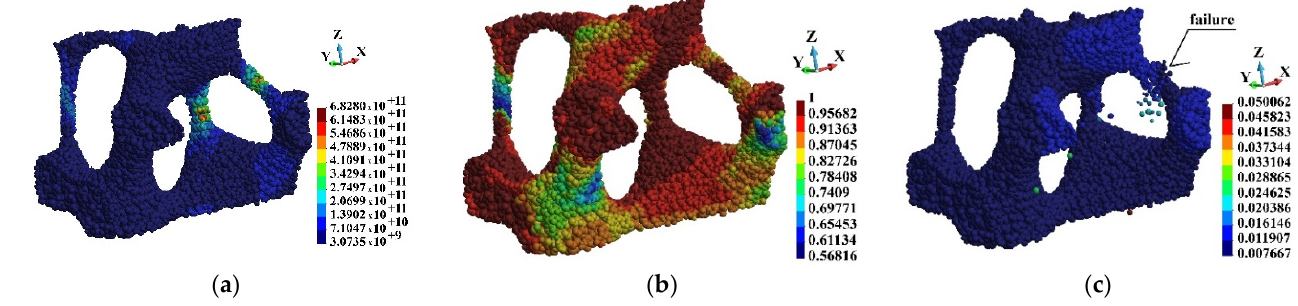
Figure 21. Region o2: ( a ) Mises stress distribution (Pa); ( b ) damage distribution; ( c ) displacements (m) in deformed configuration, scale factor 0.2.